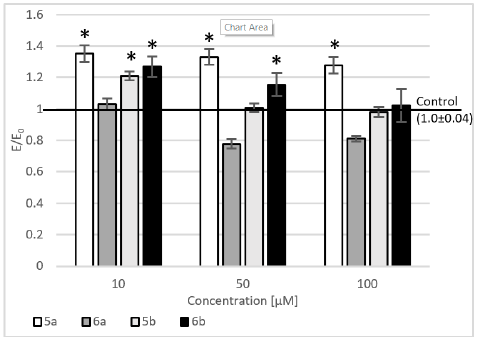
Figure 5. Effect of tested compounds on Normal Human Dermal Fibroblasts (NHDF) cells; metabolic activity measured in MTT assay; Control—cell culture incubated without tested substances; * p < 0.05—significant difference compared to control.